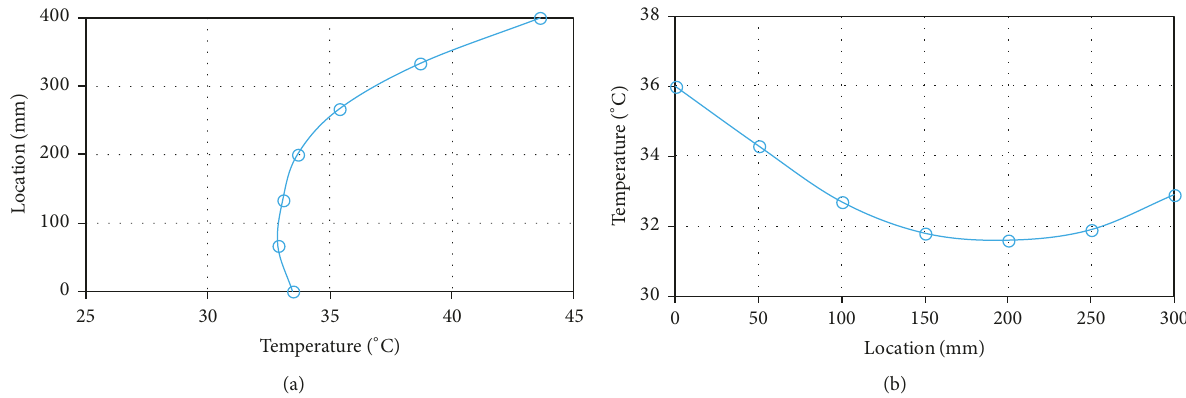
Figure 5: Temperature distribution on 27 June 2016 at 14:00 pm. (a) Along vertical direction; (b) along horizontal